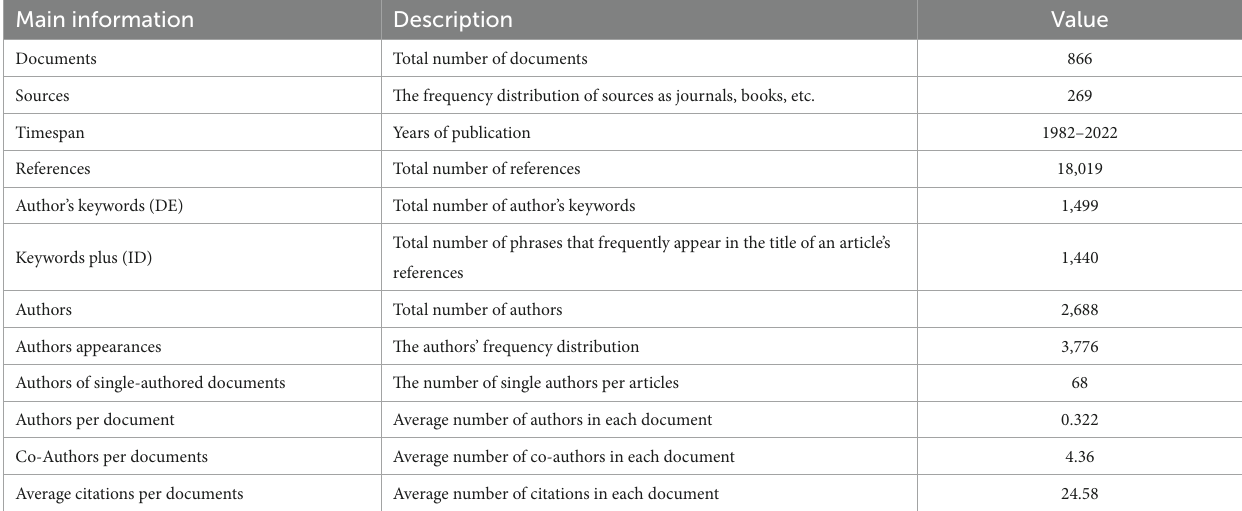
TABLE 1 Primary statistics of CEH-related literature derived from bibliometric